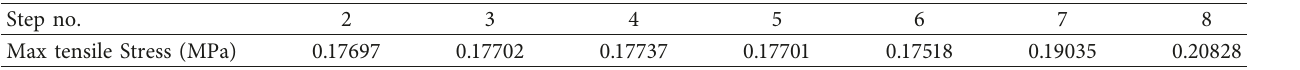
Figure 9: Isoline graph of displacement at step 8. (a) The 3D view of displacement isoline. (b) The section view of displacement isoline. Table 9: Maximum tensile stress of each step in the numerical simulation for waste dump.